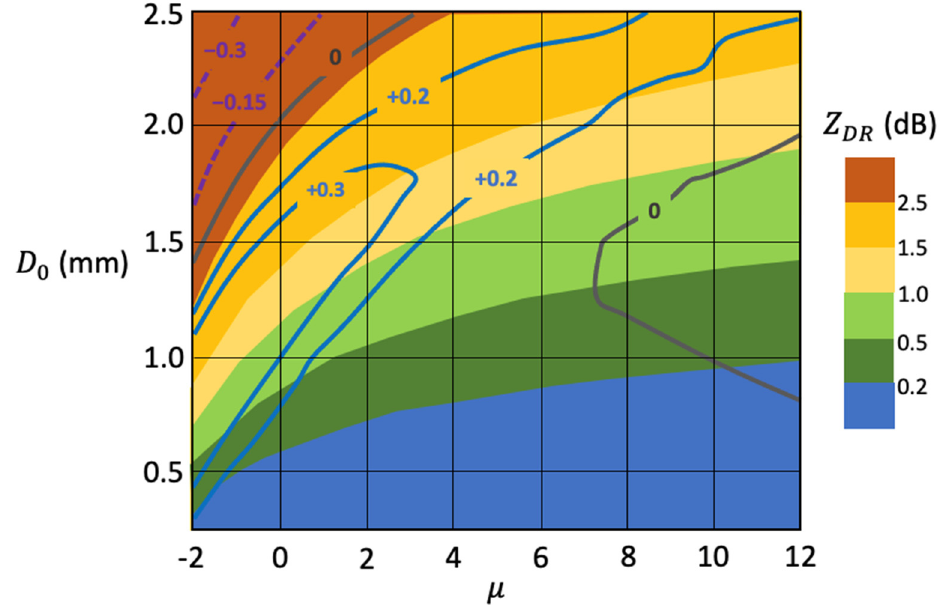
Figure 3. Adapted from [45]: color shading shows Z DR at top of rainshaft (dB according to outset scale); labeled solid contours show change in Z DR (in dB) over the 3 km rainshaft (positive indicates increase towards ground, negative indicates decrease towards ground) as follows: gray is zero change, blue contours are +0.2 and +0.3 dB; purple dashed lines are − 0.15 and − 0.3 dB. Results are shown as a function of initial gamma DSD (i.e., at the top of the domain) shape parameter 𝜇 on the abscissa and mean volume diameter D 0 on the ordinate. Computations were performed for X band.